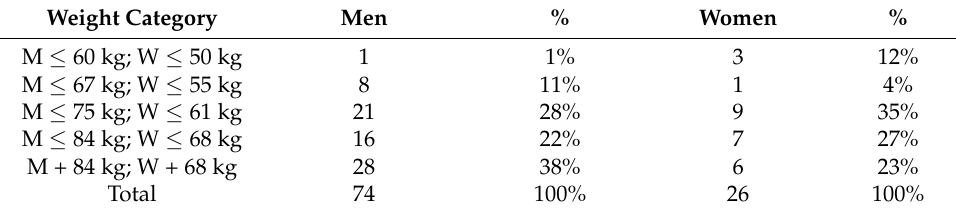
Table 1. Number of respondents by weight and sex.